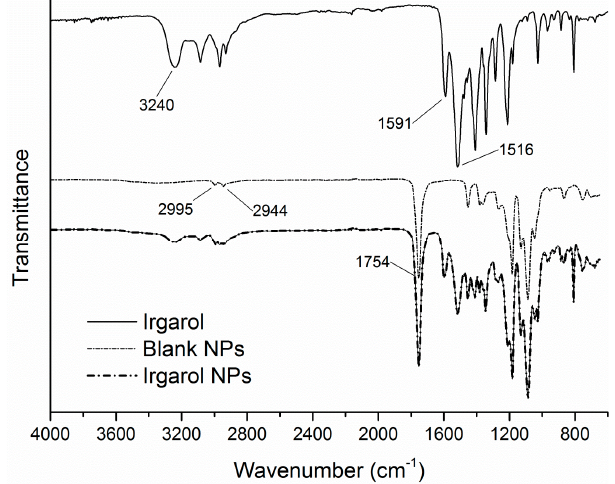
Figure 4. FTIR-ATR spectrum of Irgarol NPs and comparison spectra.